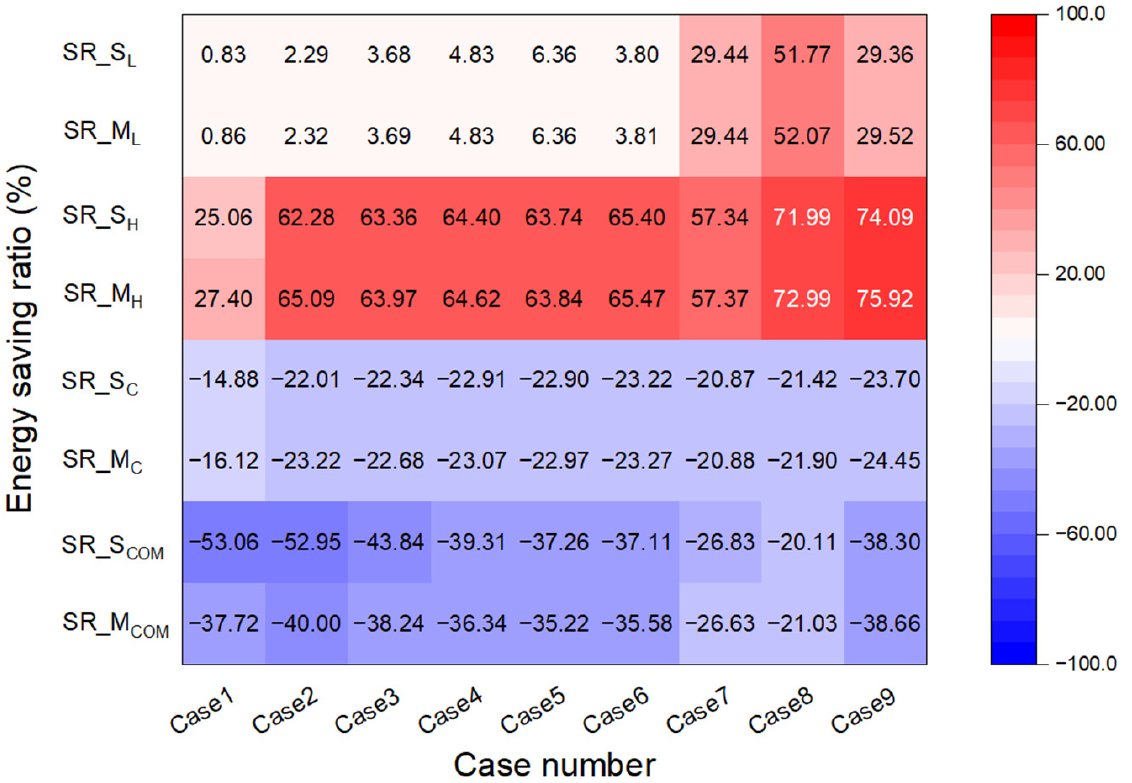
Figure 15. Energy saving analysis of building with different PVSDs in Shanghai.